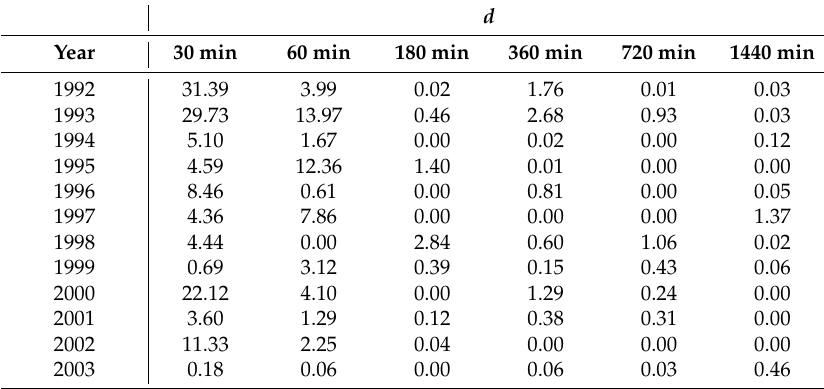
Table 3. Single underestimation errors, E % , (in%) in the determination of the annual maximum rainfall depth considering rainfall data with temporal resolution equal to 30 min and various durations, d , at the Nocera Umbra rain gauge, located in the Umbria Region. For each d , the average underestimation error, E a% , is also